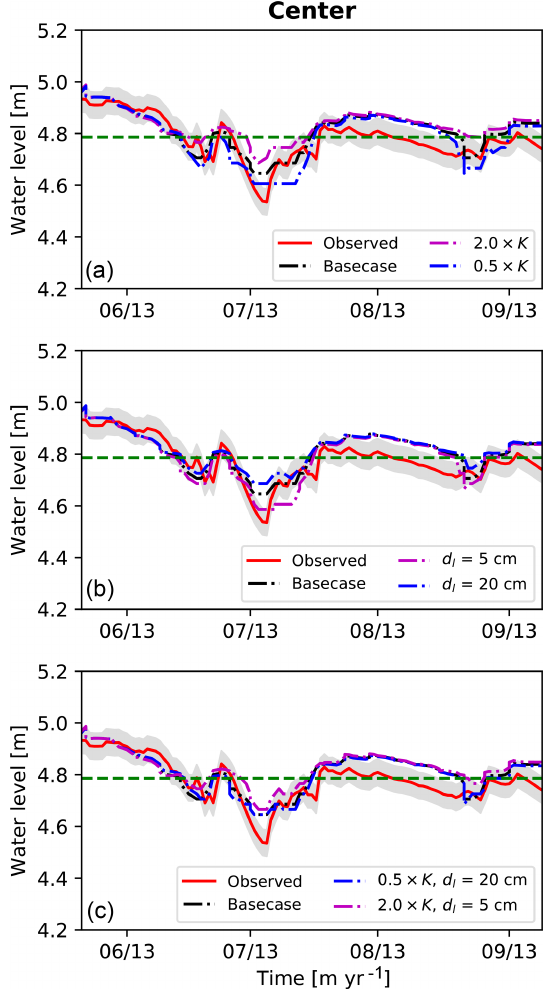
Figure 8. Observed water level at polygon center versus time in the summer of the year 2013 showing sensitivity of the simulated water level to the (a) bare soil evaporation model parameter and (b) saturated hydraulic conductivities. Enhanced drawdown is seen in (a) when the soil evaporation parameter d l is set to smaller values. Existence of a null space between saturated hydraulic conductivity and the parameter d l is shown in (c) . Basecase refers to the results in Fig. 5.